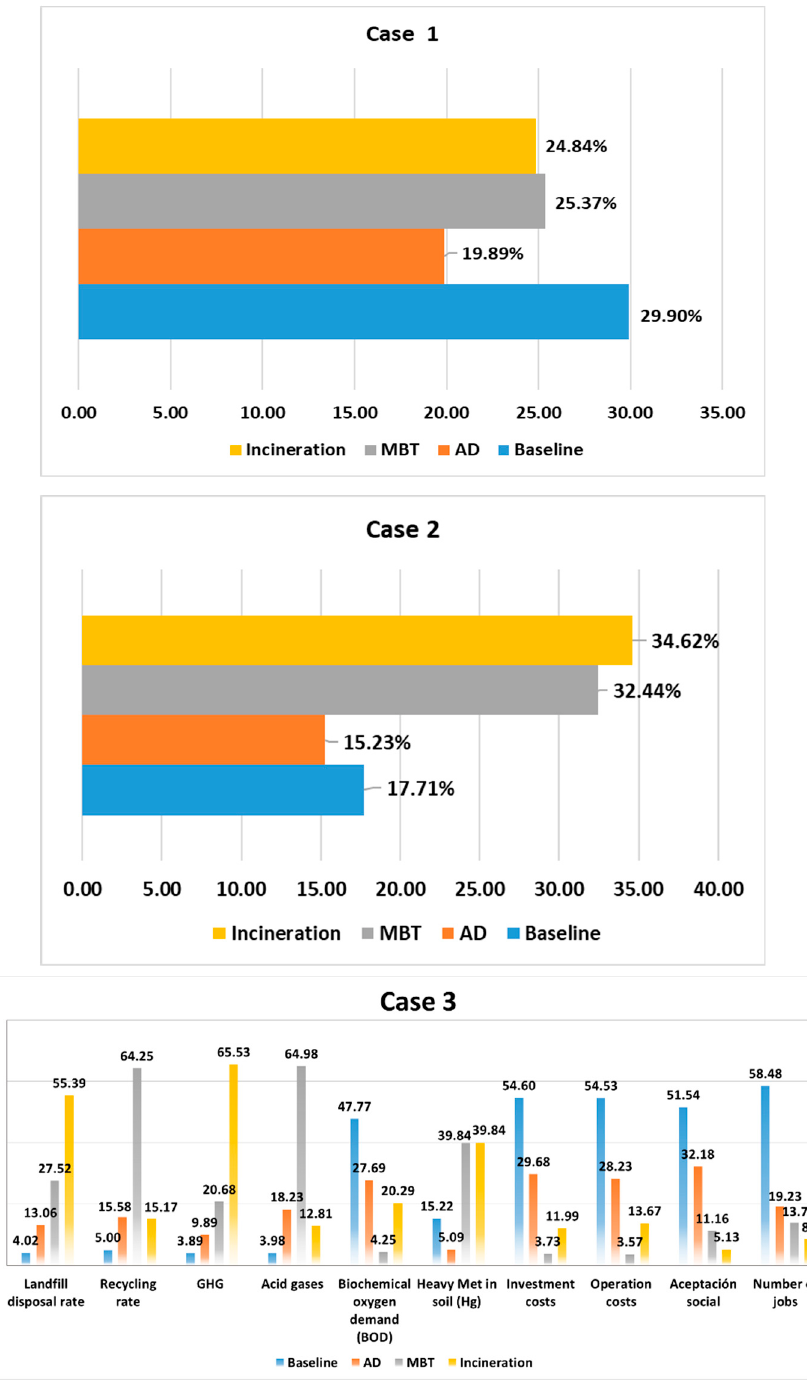
Figure 6. Results of sensitivity analysis: Case 1, Case 2, Case 3.